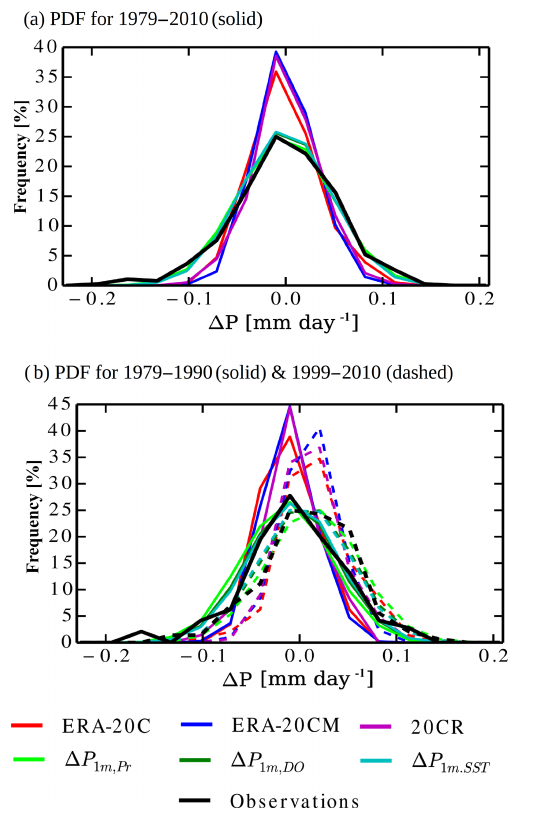
Figure 5. PDFs estimated from monthly anomaly time series for P from ERA-20C (red), ERA-20CM (dark blue), 20CR (pink), GPCP (black), (cid:49)P 1m , DO (dark green), (cid:49)P 1m , Pr (light green), and (cid:49)P 1m , SST (light blue). In (a) the PDFs are estimated for the 1979– 2010 period, and in (b) the PDFs are estimated for the 1979– 1990 period (solid) and the 1999–2010 period (dashed).